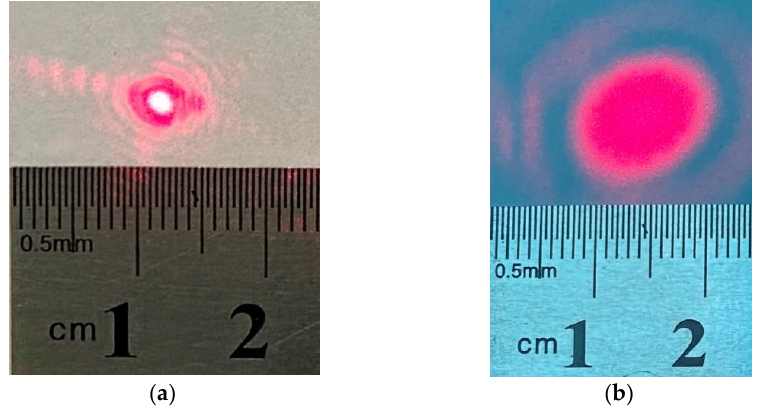
Figure 13. Alignment laser beam at the ( a ) entrance of and ( b ) exit from the collimator. The stability of output pulse energy was estimated during the alignment/tuning of the lidar laser in the methane sounding informative range (2916.55–2917 cm − 1 on-line and 2915.00 cm − 1 off-line). The measurements were carried out in the test mode of the operation of the lidar radiation source in turn on each of the informative probing lines at a pulse repetition rate of 10 Hz. The accumulation time of ~6000 pulses was 10 min. The measurement results are shown in Figure 14.